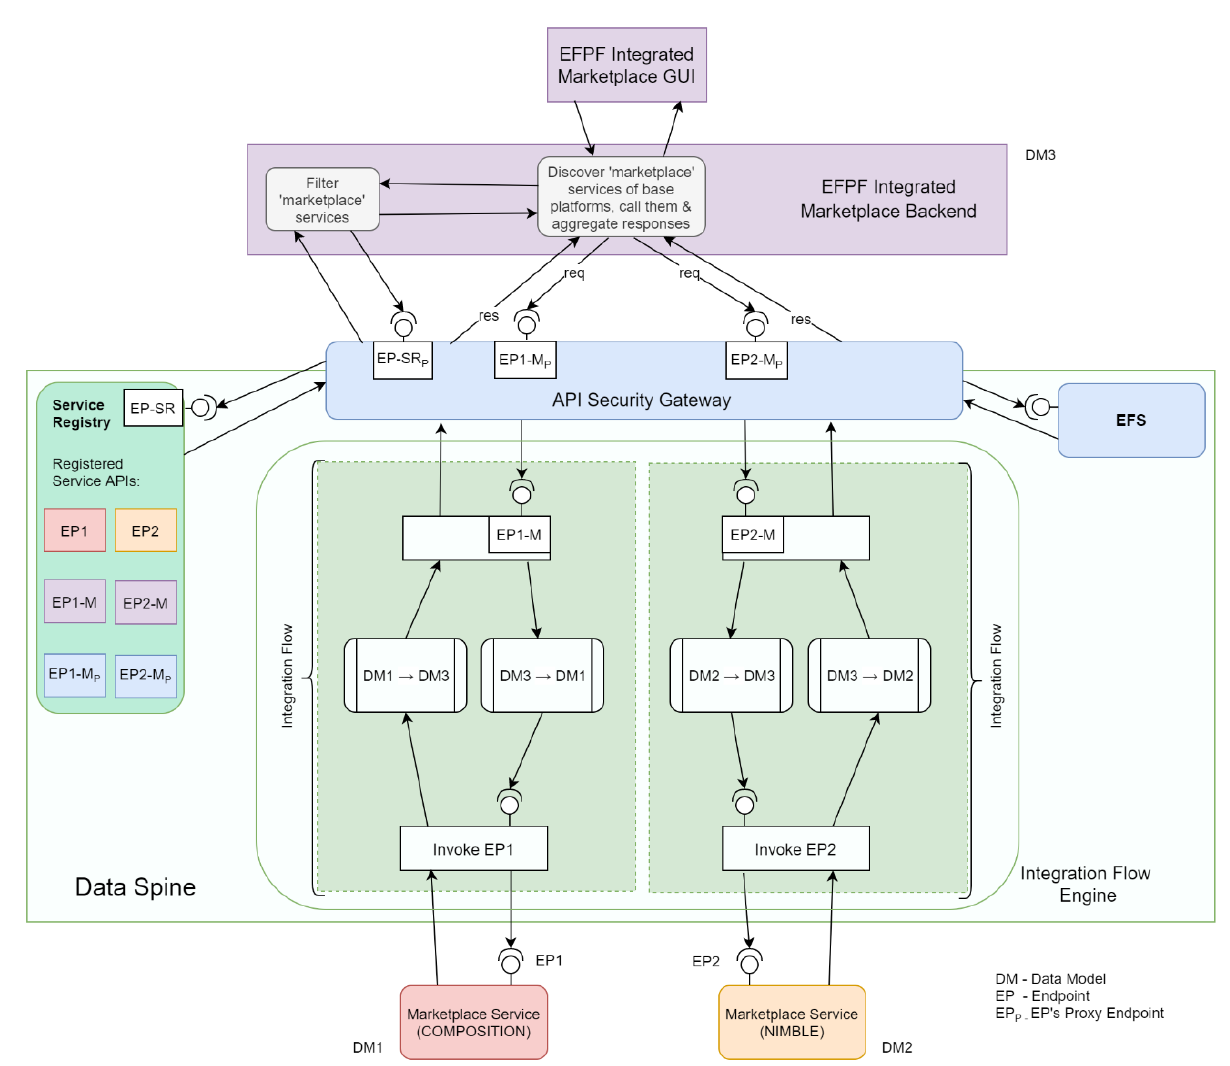
Figure 13. Realisation of an integrated marketplace solution in the EFPF ecosystem.